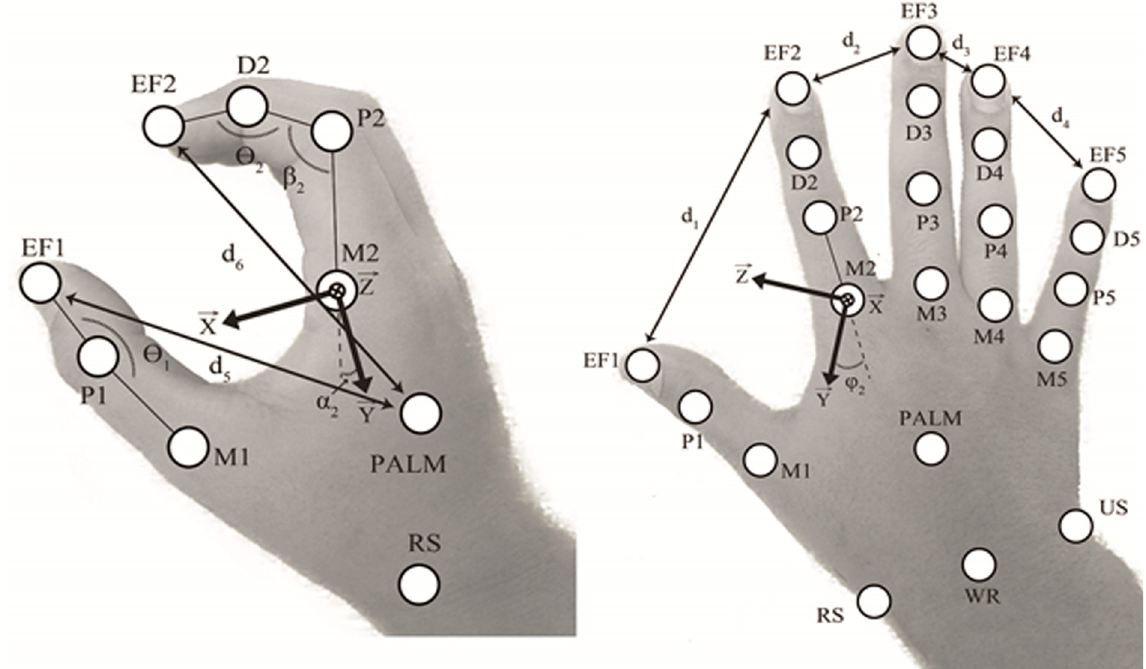
( i = 1–5): finger and thumb end-effector i